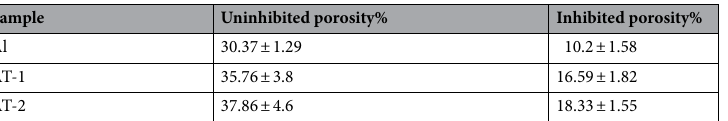
Table 3. Porosity percentage from SEM micrographs for uninhibited and inhibited Al, AT-1 and AT-2 alloys in 0.5 M HCl without and with 1 mM of 2-MBT.